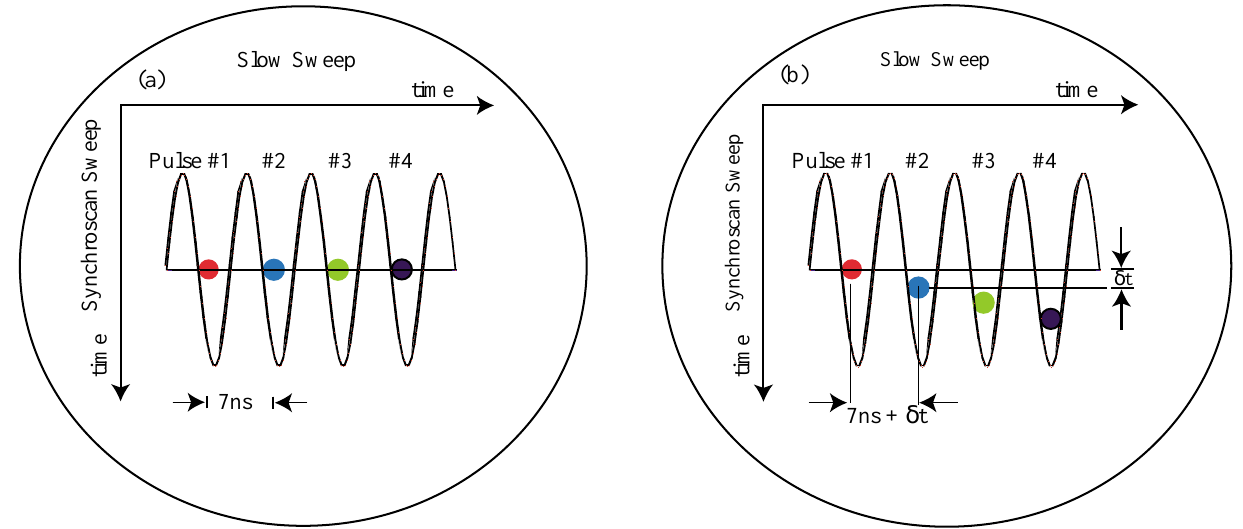
FIG. 6. (Color) (a) The four pulses separated by 7 ns readout by the streak camera and (b) the four pulses each separated by 7 1 d t ns. (displayed on the left-hand side of the image). For each image, a longitudinal profile for each light pulse is created, saved, and processed off-line. The processing includes fitting the longitudinal profile to an asymmetric Gaussian function given by